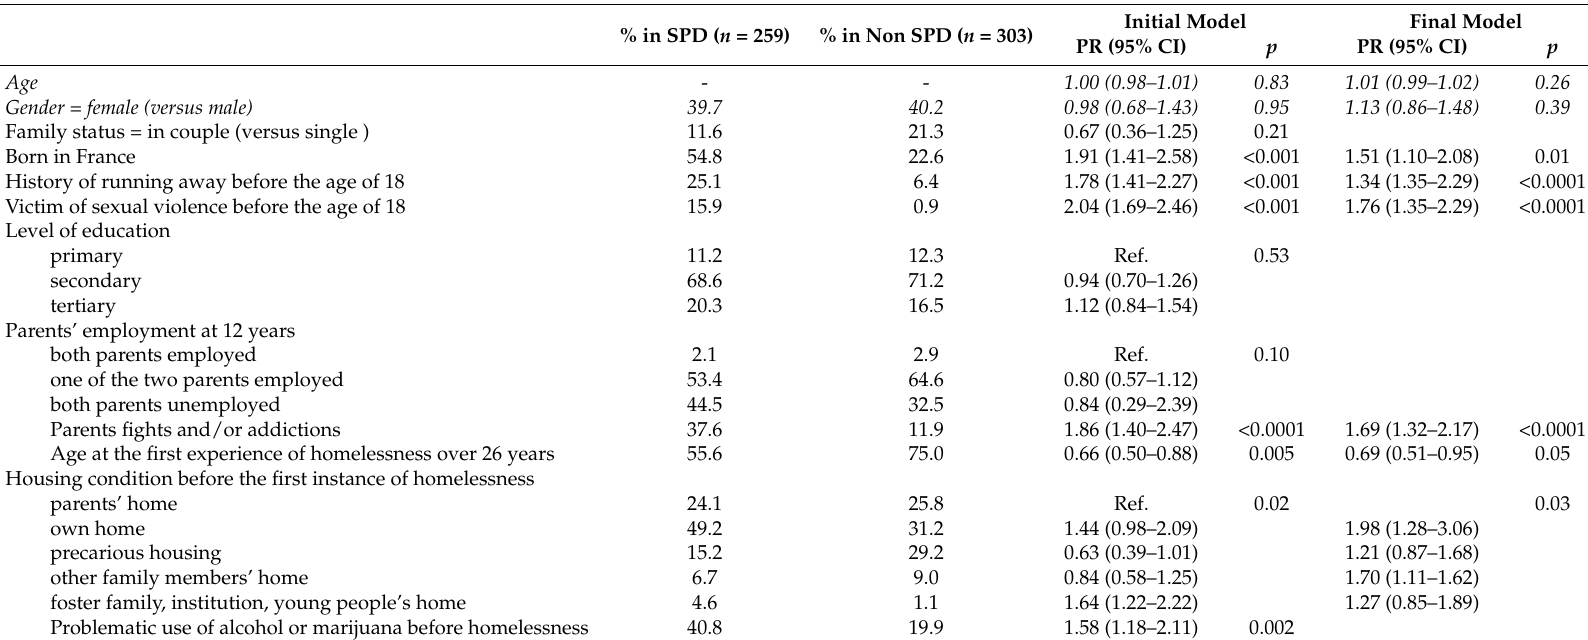
Table 2. Factors associated with severe psychiatric disorders (SPD) among homeless people, Greater Paris (France),